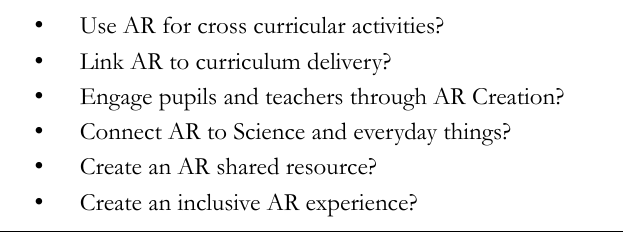
Figure 5. How Might We (Design